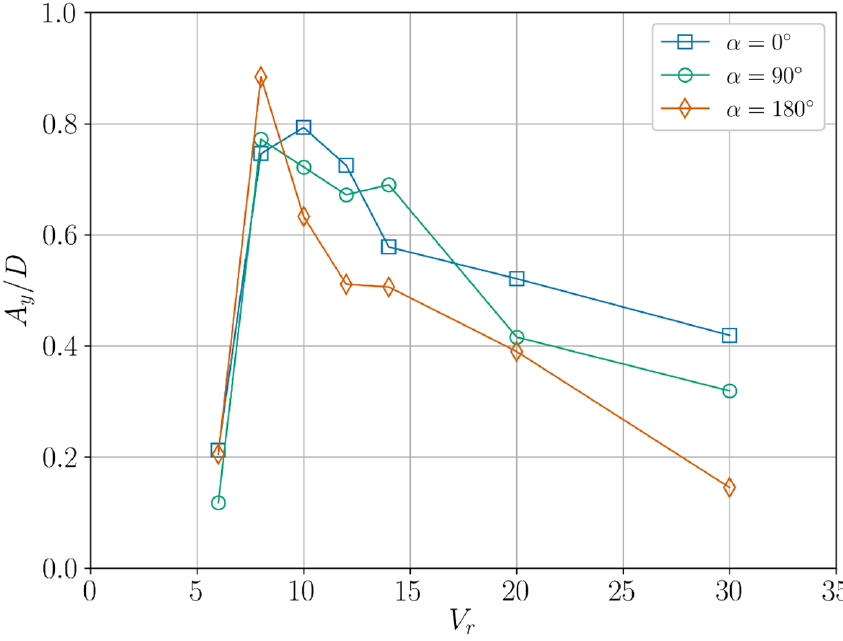
Figure 9. Transverse response amplitude of FOWT platform under different current incidence.